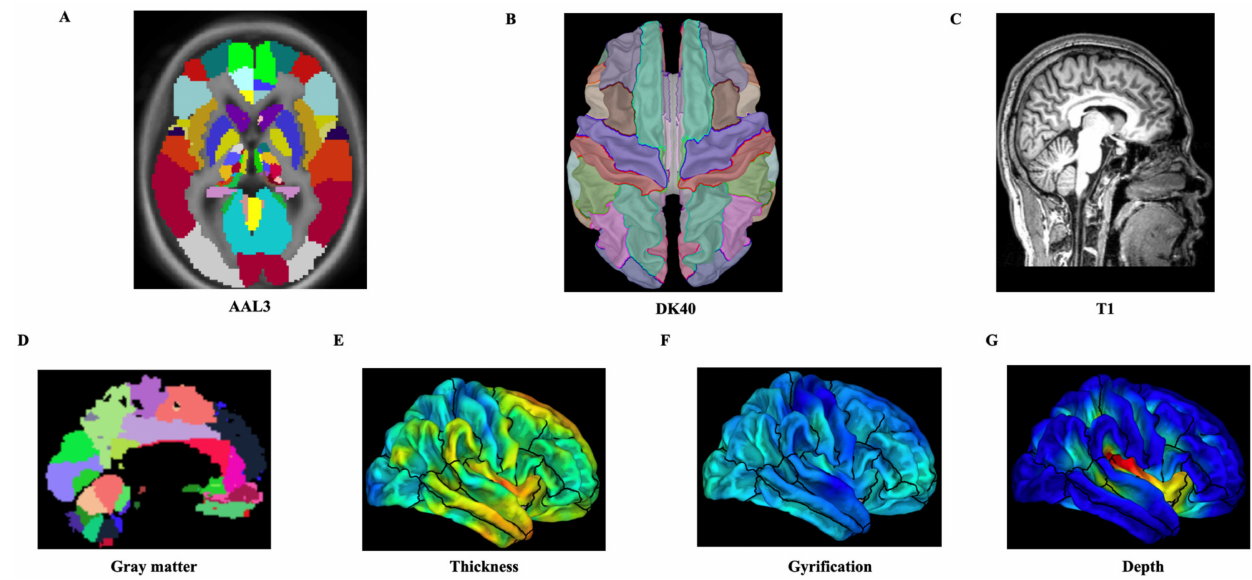
Figure 1. The extracted four cortical structure indices from the original MRI images based on different templates. ( A ) The template of AAL3; ( B ) the template of DK 40; ( C ) the raw MRI image of a subject; ( D ) the gray matter map of the subject with AAL3; ( E ) the cortical thickness of the subject with DK 40; ( F ) the gyrus of the subject with DK 40; ( G ) the sulcal depth of the subject with DK 40. ( A , B ) were shown by the Brainstorm; ( C ) was shown by MRIcron; and ( D – G ) were shown by the CAT12. Abbreviations: AAL3, automated anatomical labelling 3; DK 40, Desikan–Killiany atlas.